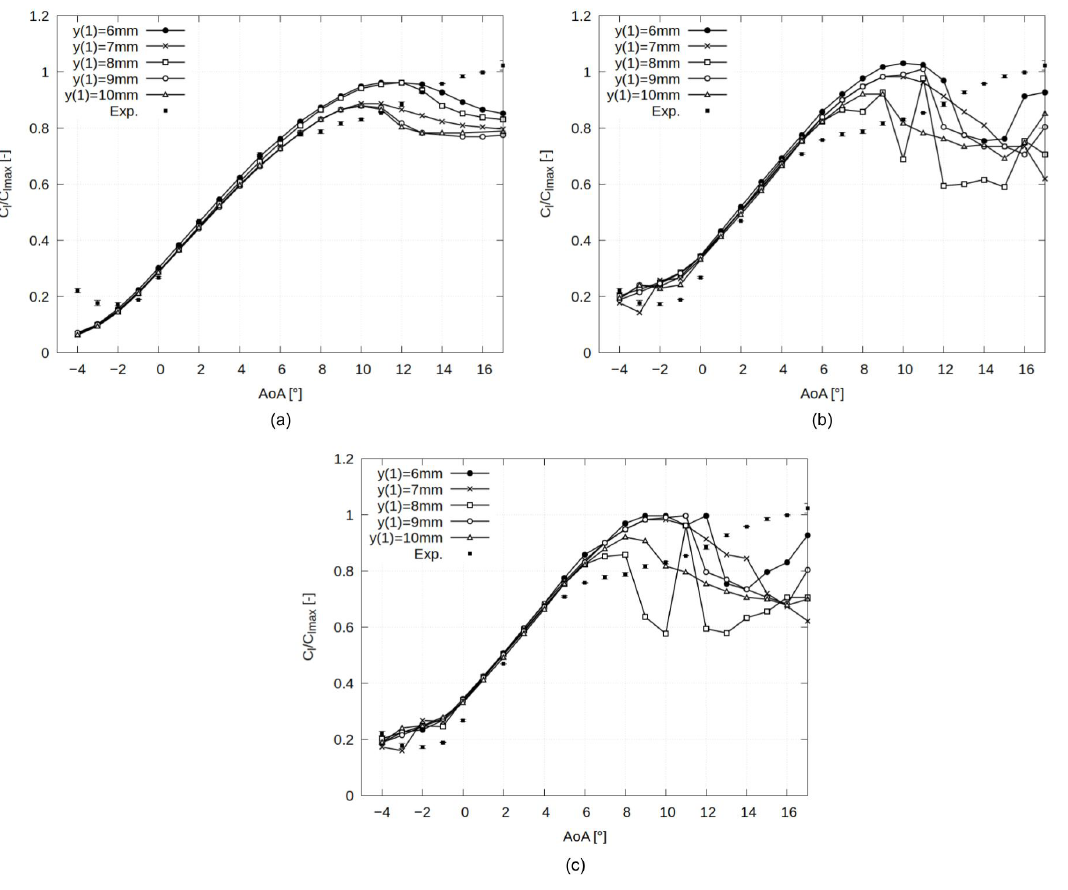
Figure A2. C l vs. AoA of profile 2 for different first cell heights y ( 1 ) using ( a ) Momentum, ( b ) DLR, and ( c ) Colebrook